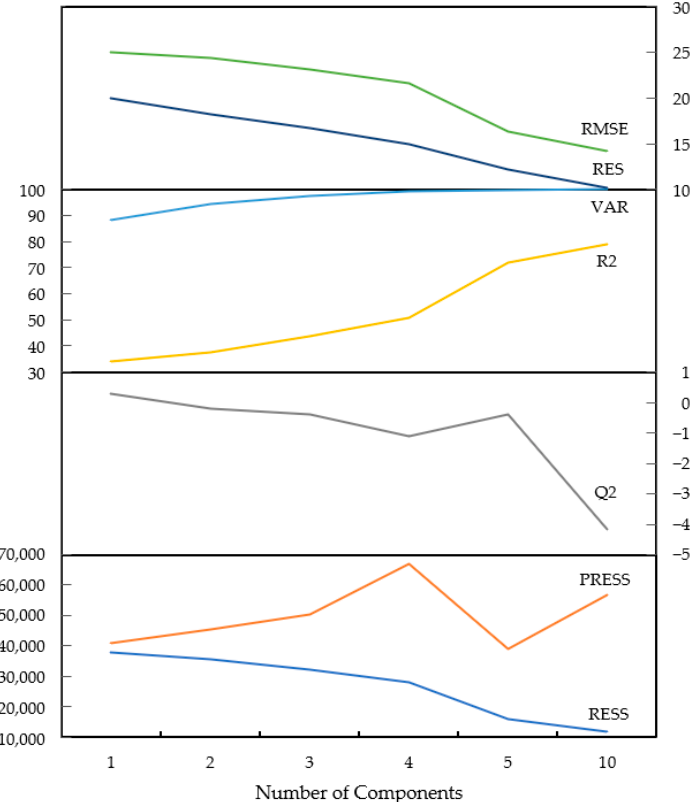
Figure 6. Stacked panel line chart for a variety of quality of prediction statistics tabulated for each of the 1, 2, 3, 4, 5 and 10 component scenarios. Abbreviation definitions: RMSE = root mean squared error; RES = mean absolute residual (all samples); VAR = percentage of model variance explained; R2 = coefficient of determination (×100); Q (cid:2870) criterion (as in Equation (6)); PRESS statistic (as in Equa- tion (5)); RESS statistic (as in Equation (4)).